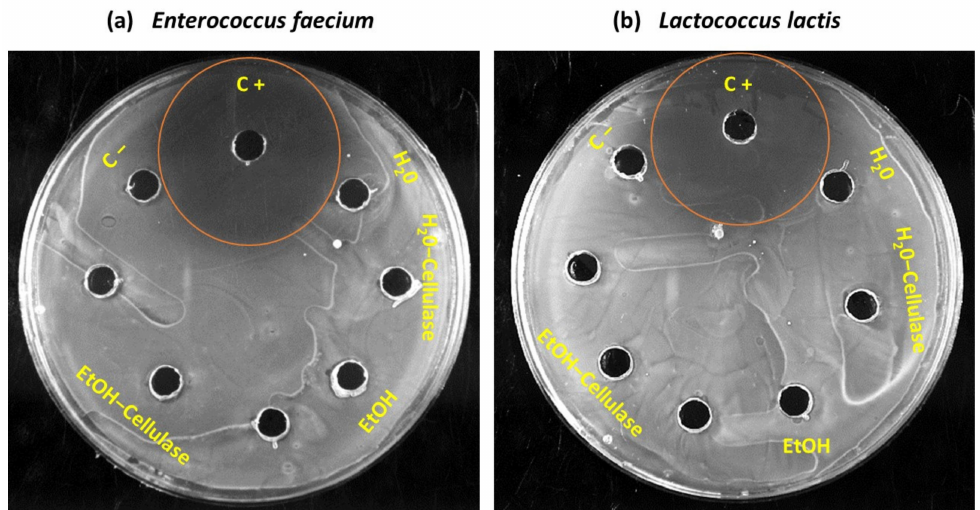
Figure 2. Evaluation of growth inhibition factors of ( a ) Enterococcus faecium and ( b ) Lactococcus lactis in Aloe vera extracts. C+ = Positive control; C − = Negative control; EtOH =